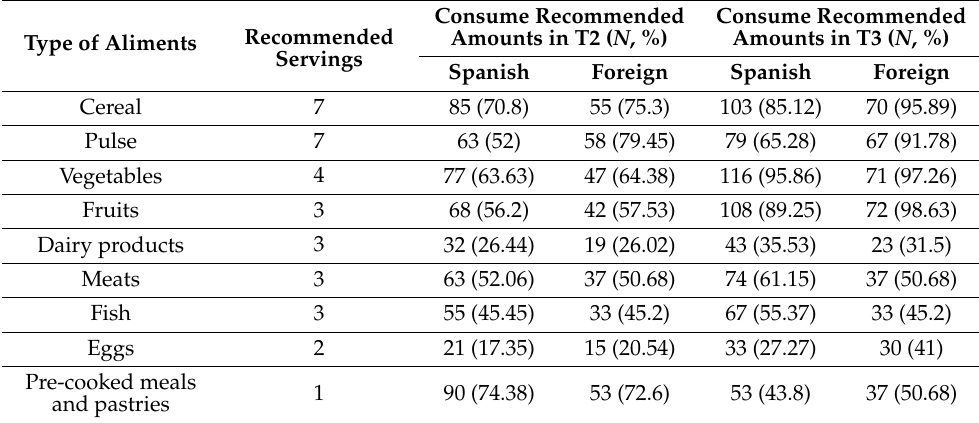
Table 2. Nutritional habits of 194 women included in the study.